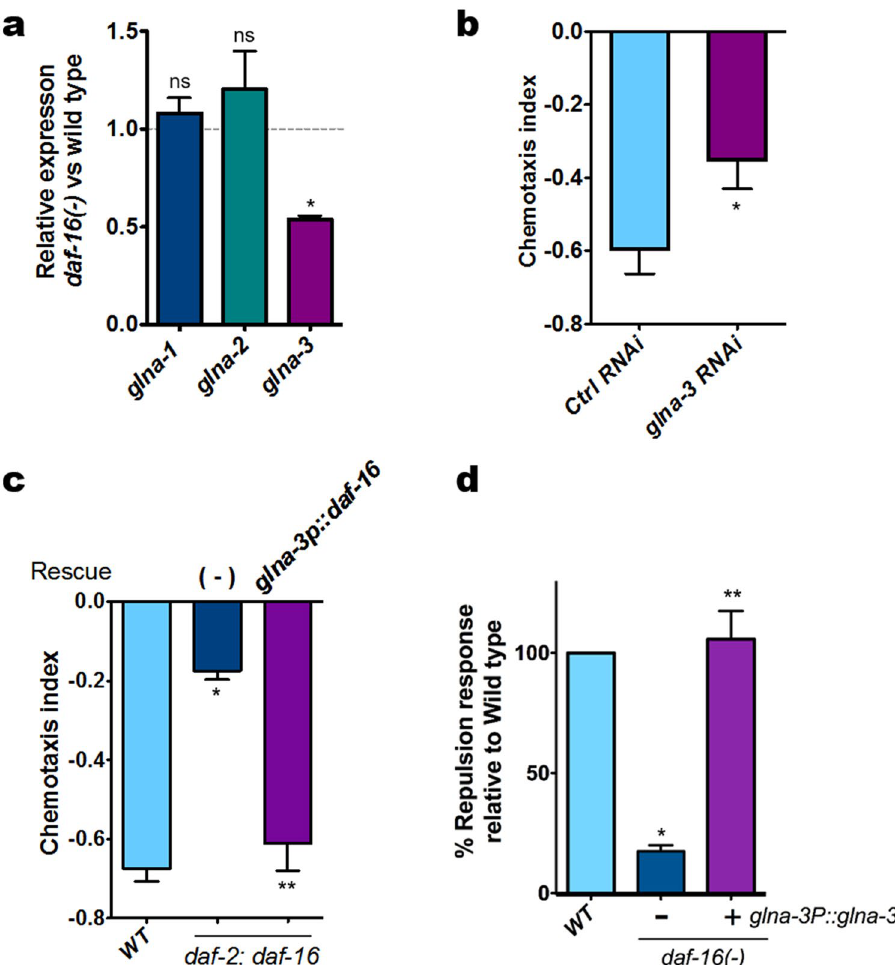
Figure 2. DAF-16/FoxO regulates glna-3 expression. ( a ) Glutaminase gene transcript levels in daf-16/FoxO mutants. Bars represent the mean of three independent biological replicates. * P < 0.05 , ns: not significant compared to wild type. ( b ) RNAi against glna-3 in a neuronal RNAi-sensitive strain ( unc-119P::sid-1 ). F1 animals were hatched and grown on control or glna-3 RNAi plates. F1 young adults were transferred to new RNAi plates and allowed to lay eggs, and F2 young adults were tested (Ctrl RNAi, n = 148; glna-3 RNAi, n = 163). * P < 0.05 compared to Ctrl RNAi ( c ) DAF-16/FoxO in glna-3 -expressing neurons rescued the daf- 2;daf-16/FoxO phenotype (wild type, n = 88; daf-2;daf-16/FoxO, n = 101; daf-2;daf-16/FoxO ; glna-3P::DAF-16/ FoxO , n = 82). DAF-16/FoxO cDNA was expressed under control of the glna-3 promoter. * P < 0.05 compared to wild type, ** P < 0.05 compared to daf-2;daf-16/FoxO. ( d ) glna-3P::glna-3 rescued daf-16/FoxO mutant phenotype (wild type, n = 150; daf-16/FoxO , n = 149; daf-16/FoxO;glna-3P::glna-3 , n = 150). * : daf-16 ( - ) vs daf-16 ( - ) ; glna-3P::daf-16 . Bars represent the mean of three independent biological replicates. Significance was determined using two-tailed, unpaired t